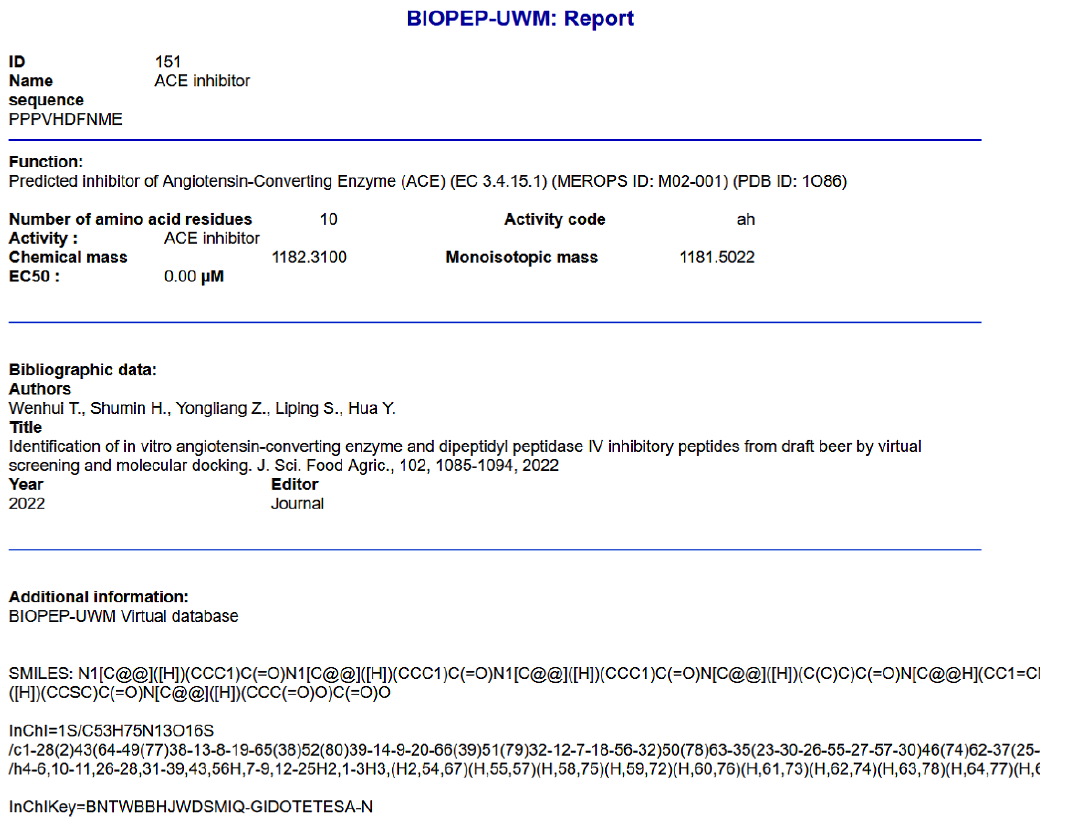
Figure 5. Screenshot of the content from the tab “Screen and print peptide data” (see Figure 3): an exemplary peptide with BIOPEP-UWM Virtual ID: 151.